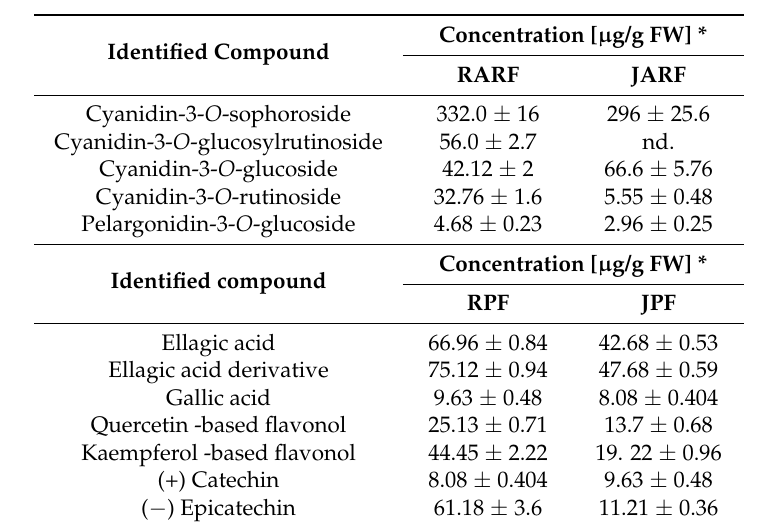
Table 2. Identified compounds concentration in anthocyanin rich fraction (ARF) and other phenolic fraction (PF) from raspberry pulp (R) and juice (J) determined by HPLC